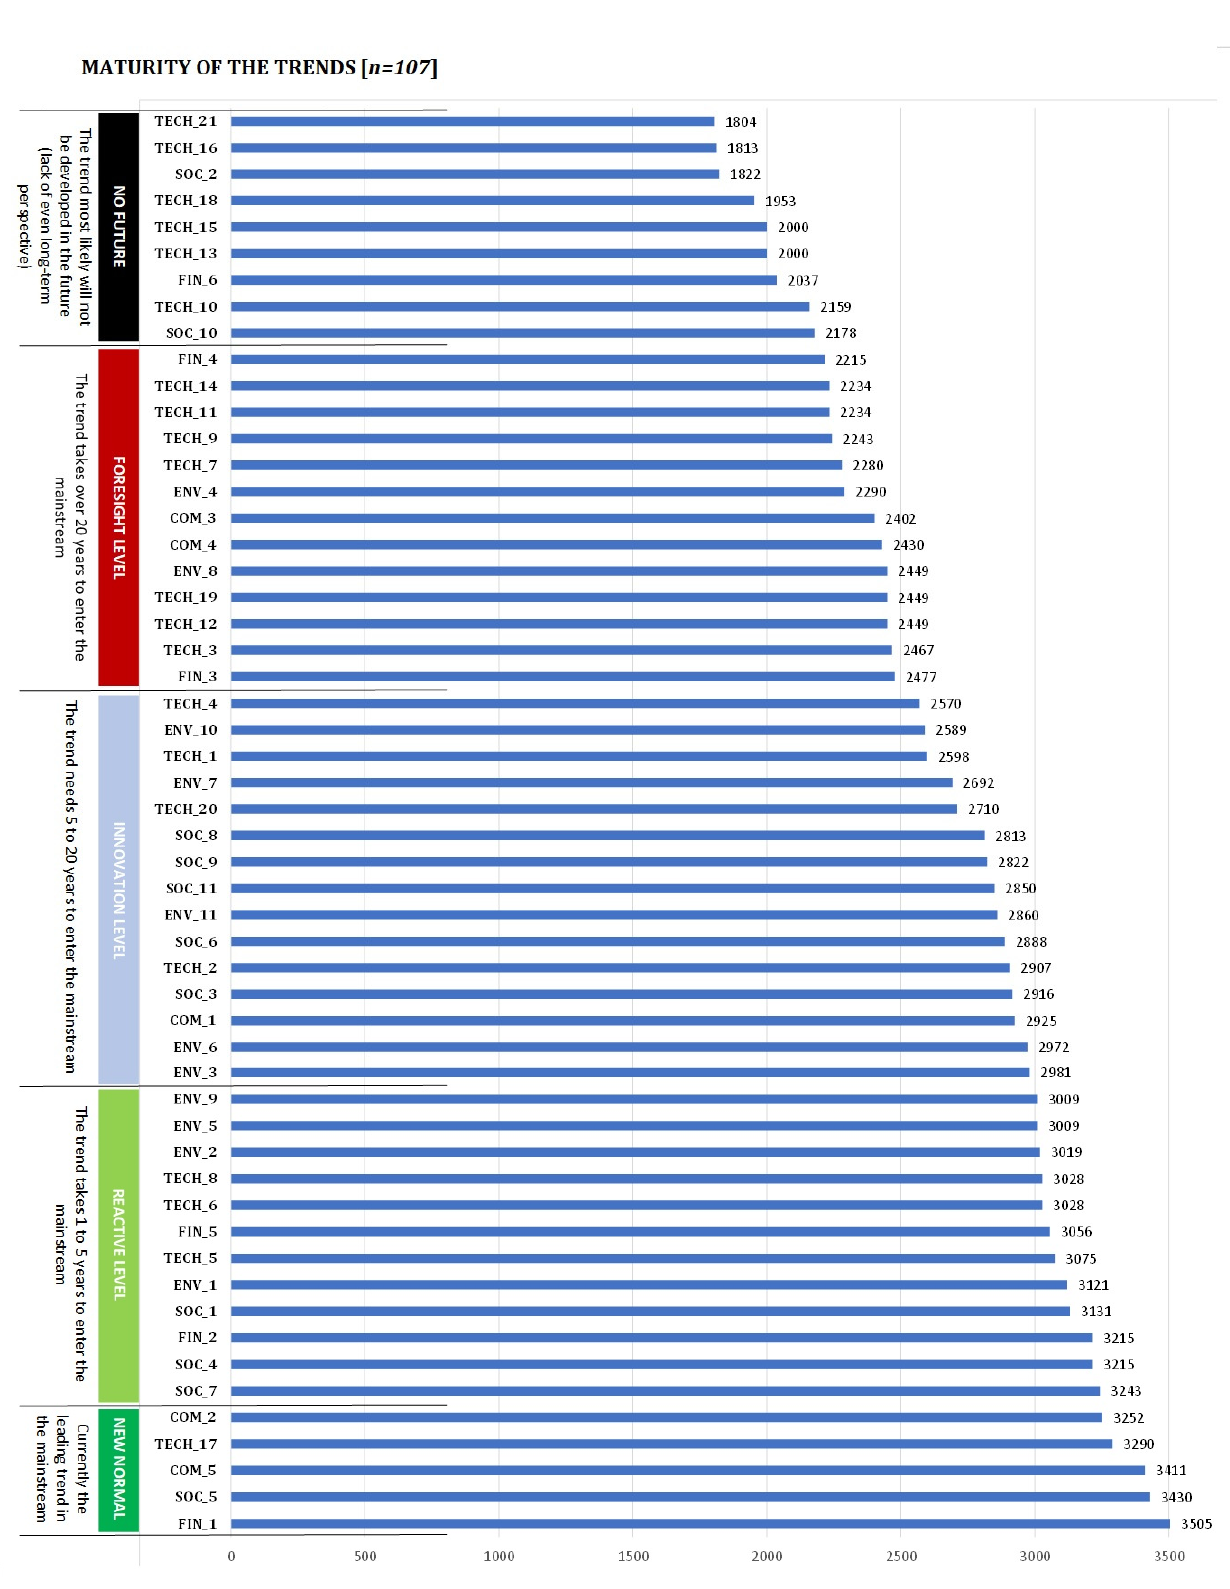
Figure 5. Map of Maturity of S.T.F.E.C. SMART management trends—overall results. Source: Own elaboration.